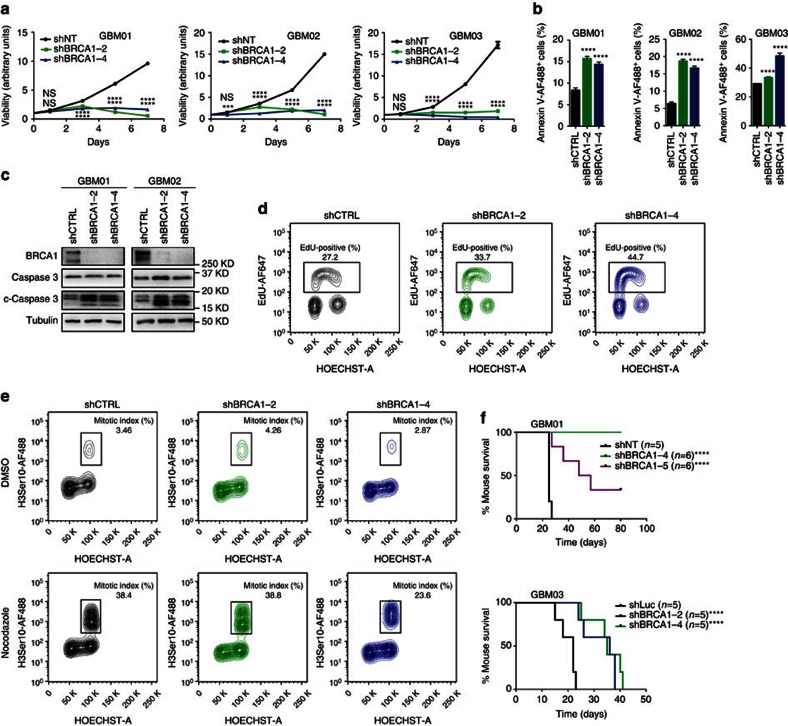
BRCA1 is essential for GBM cell maintenance.(a) Viability curves for GBM01, GBM02 and GBM03 cells transduced with shCTRL virus or two independent BRCA1-targeting shRNAs (shBRCA1-2 and shBRCA1-4) (7 days). (b) Quantification of apoptotic cells (% of Annexin V-positive) for GBM01, GBM02 and GBM03 cells transduced with shCTRL virus or two independent BRCA1-targeting shRNAs (shBRCA1-2 and shBRCA1-4). (c) Immunoblot analysis of BRCA1, caspase 3 and cleaved caspase-3 in GBM01 and GBM02 cells transduced with shCTRL virus or two independent BRCA1-targeting shRNAs (shBRCA1-2 and shBRCA1-4). Tubulin was used as a loading control. (d) FACS analysis of cell cycle profile and the proliferative index (% of Edu-positive cells) in GBM01 cells transduced with shCTRL virus or two independent BRCA1-targeting shRNAs (shBRCA1-2 and shBRCA1-4). (e) FACS analysis of cell cycle profile and the mitotic index (% of H3Ser10-positive cells) in DMSO or nocodazole treated GBM01 cells transduced with shCTRL virus or two independent BRCA1-targeting shRNAs (shBRCA1-2 and shBRCA1-4). (f) Kaplan-Meier survival curve for NMRI nude mice intracranially injected with GBM01 or GBM03 cells transduced with shCTRL virus or two independent BRCA1-targeting shRNAs (shBRCA1-2 and shBRCA1-4 or shBRCA1-5). Statistical significance was calculated by one-way ANOVA, Tukey’s multiple comparisons test (in vitro study) and Log-rank/Mantel-Cox test (in vivo study). All data are shown as means±s.d. and performed as technical triplicates. (*P<0.05, **P<0.005, ***P<0.005, ****P<0.0001; NS represents non-significance).